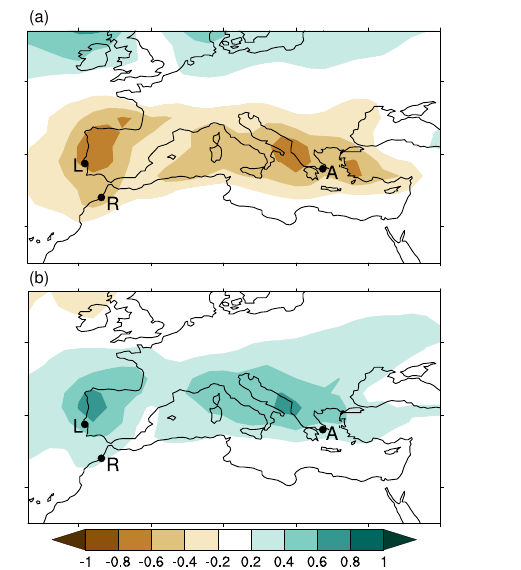
Figure 13. Spread in projected winter (DJF) precipitation changes for the Mediterranean. Composites of precipitation anomalies (mmd − 1 ) over the members with the (a) strongest 5% and (b) weakest 5% of u 850 responses within each model ensem- ble in the 2.0 ◦ C experiment. Strong u 850 responses are defined as those with most weakening of the mean westerlies over North Africa (Fig. 12b). Labels indicate the locations of Rabat, Lisbon, and